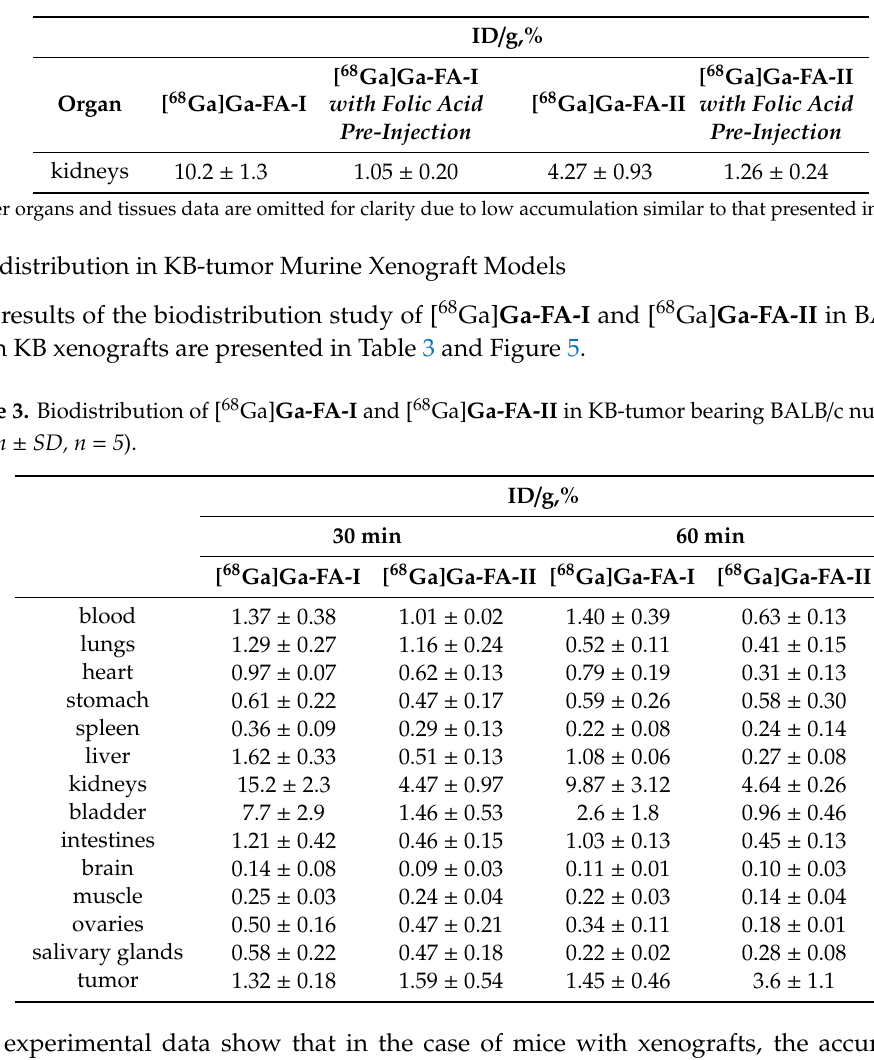
Table 2. Accumulation of [ 68 Ga] Ga-FA-I and [ 68 Ga] Ga-FA-II in the kidneys * of normal Wistar rats ( mean ± SD, n = 3 ) 60 min after i.v. injection with / without folic acid pre-injection.